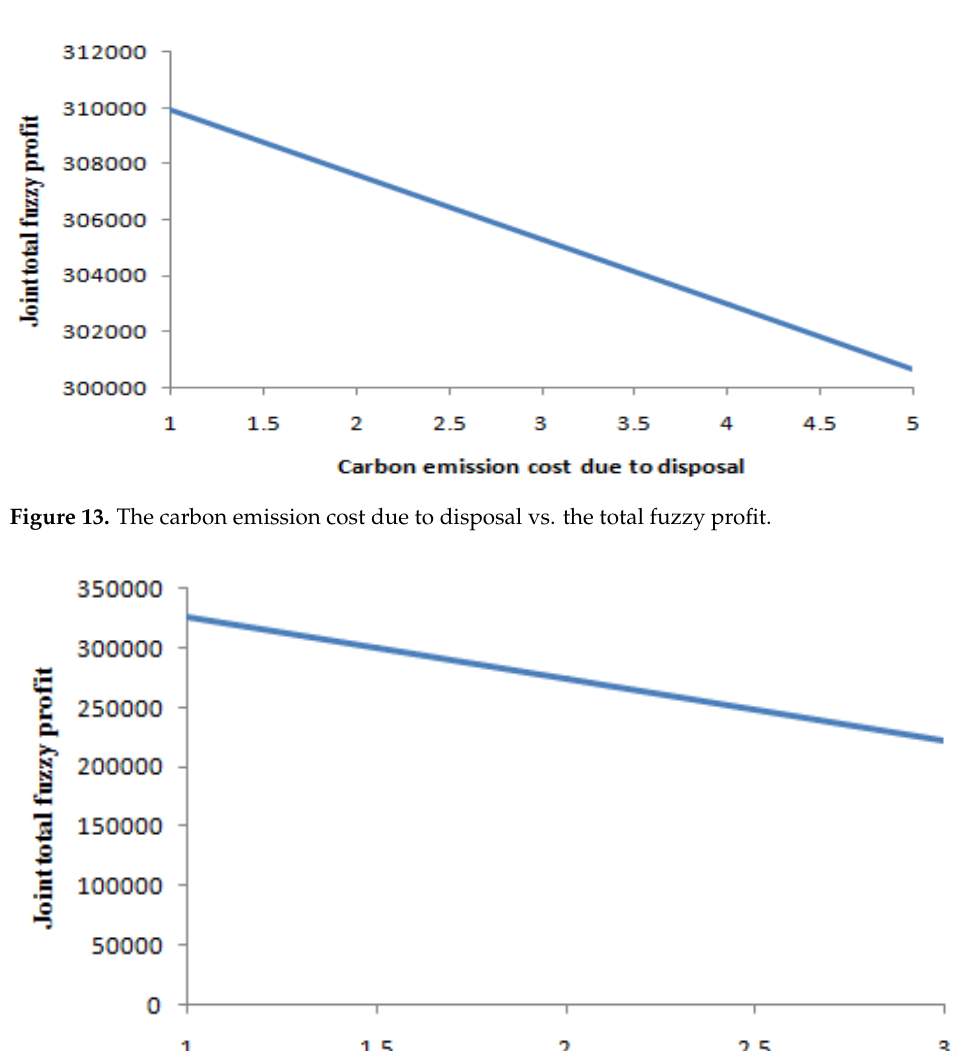
Figure 14. The carbon emission cost due to production vs total fuzzy profit.